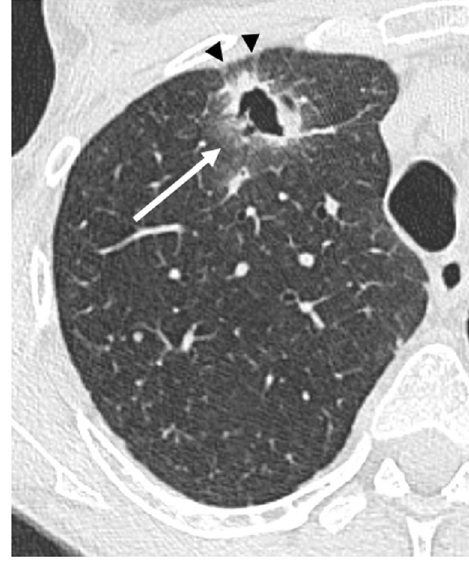
Fig. 20 Primary epidermoid lung carcinoma. Asymptomatic, cavitated nodule on follow-up chest X-ray. Cavitated nodule with spiculated margins ( arrow ) and pleural traction ( arrowheads